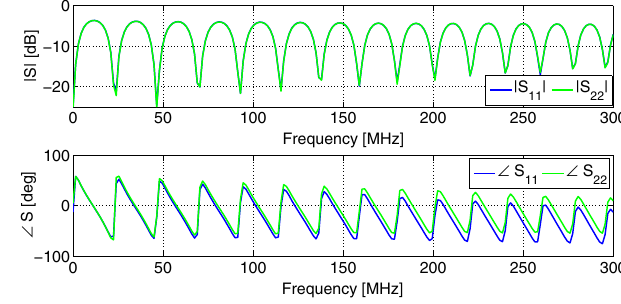
the two transmission lines: L 1 (cid:1) L 2 . The S parameters measured for this configuration by means of the network (cid:3)(cid:3) S meas in Fig. 4), are shown in analyzer (indicated as tensor Figs. 5 and 6, for a typical 50 (cid:1) normalization impedance.